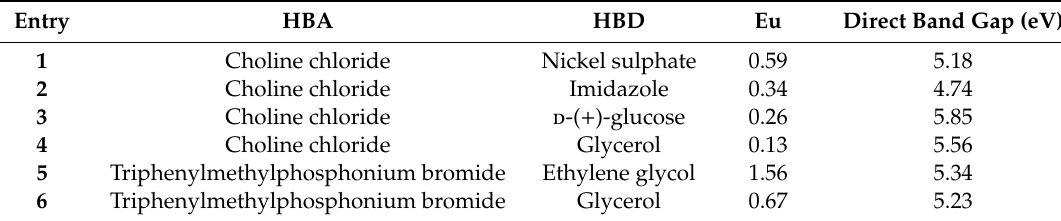
Table 3. Urbach energies for Systems 1 – 6 .